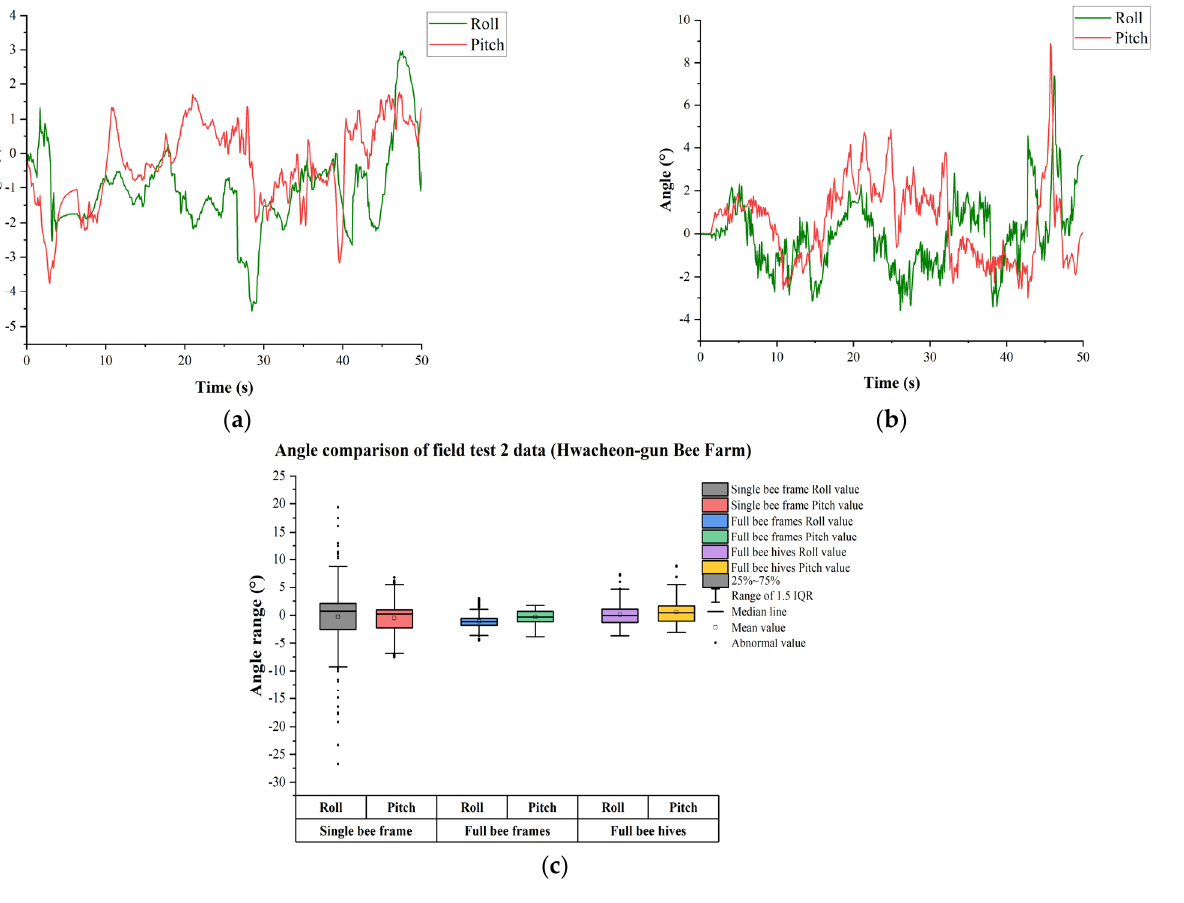
Figure 29. Angle variation of ( a ) the vehicle fully loaded with bee frames during actual transportation, ( b ) the vehicle fully loaded with beehives during actual transportation, and (c) all vehicles during actual transportation. Table 4. Summary of the simulation and field test results.